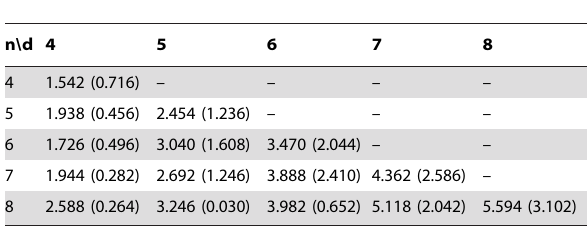
Table 2. Data with three combinatorial